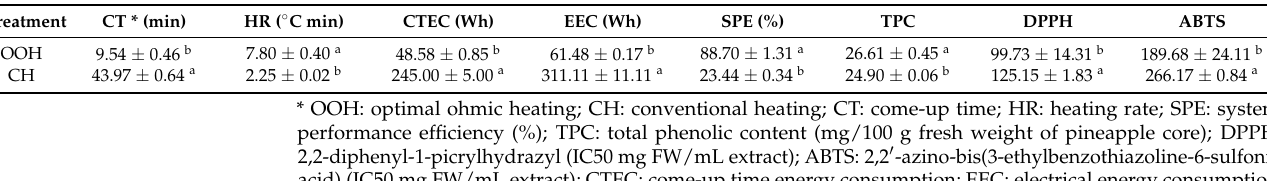
Table 3. Comparison of optimization in ohmic heating and conventional